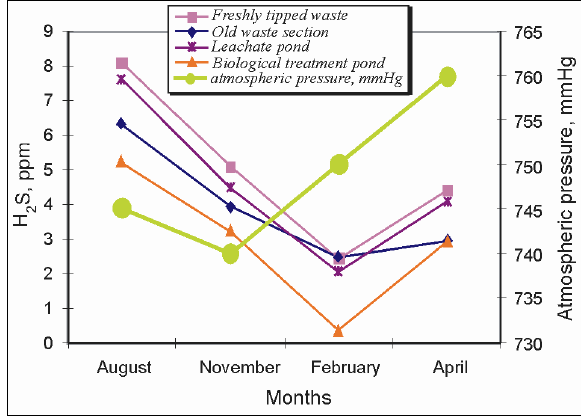
Fig. 6. H 2 S concentration dependence on air humidity Fig. 7. H 2 S concentration dependence on atmospheric